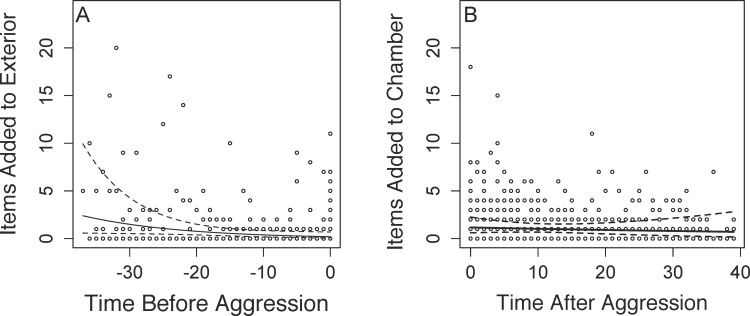
(A) Negative relationship between the number of items added to the thatch of the nest and the number of observation blocks before suffering aggression. (B) Negative association between the number of items added to a nest chamber and the time after suffering aggression. Each unit represents one observation block (3 hours), and we completed two observation blocks per day. Therefore 2 units on these axes represent 24 hours. In both plots the solid line is the predicted line from the linear model while the dashed lines represent the 95% confidence interval around the line.